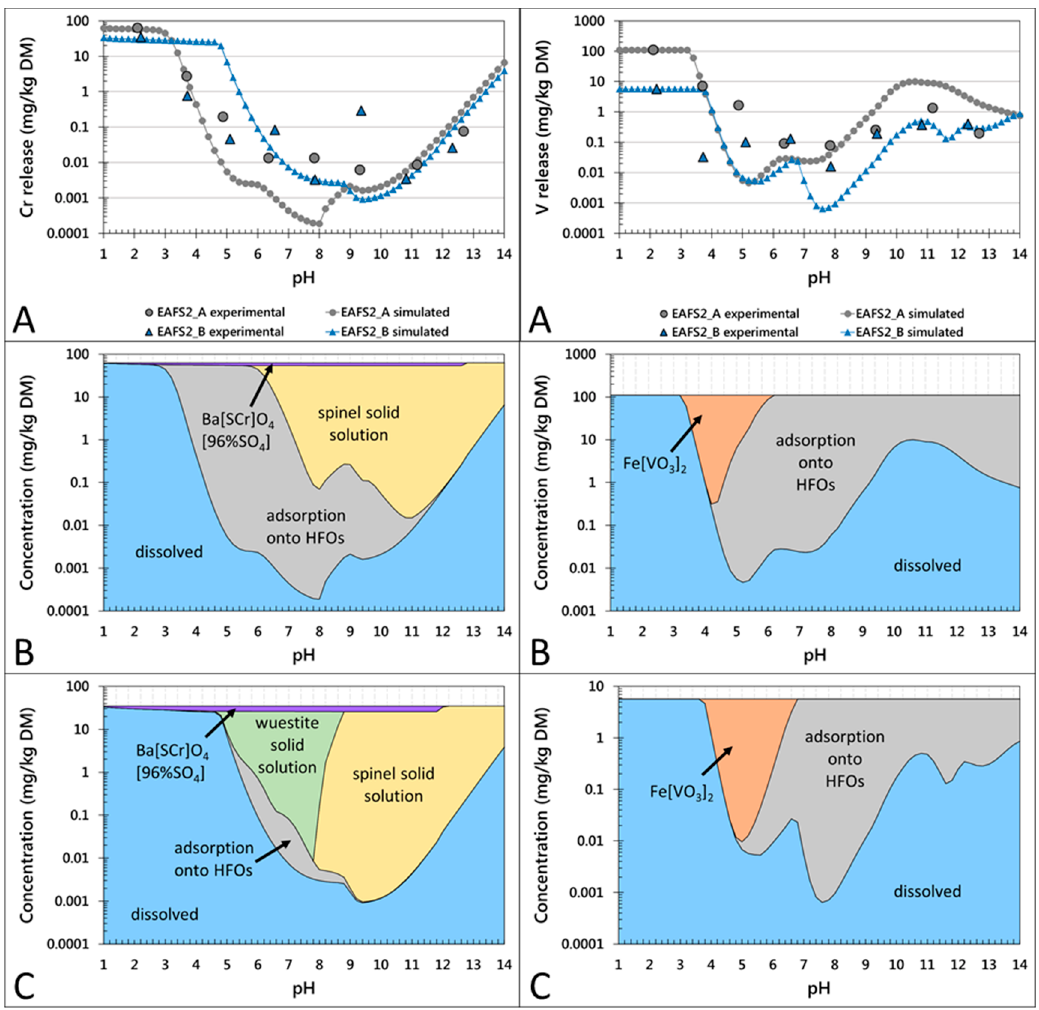
Figure 3. pH-dependent leaching behavior of Cr ( left column ) and V ( right column ) in the conditioned EAF slag samples EAFS2_A and EAFS2_B. Partitioning in the solution ( A ) and in the solid ( B , C ) are given on a weight basis. ( A ) Experimentally determined release of Cr and V, respectively (larger symbols without line) and calculated results with LeachXS TM / Orchestra (corresponding symbols with lines). ( B , C ) Calculated concentrations of leaching control phases / mechanisms for Cr and V, respectively, in samples EAFS2_A ( B ) and EAFS2_B ( C ).